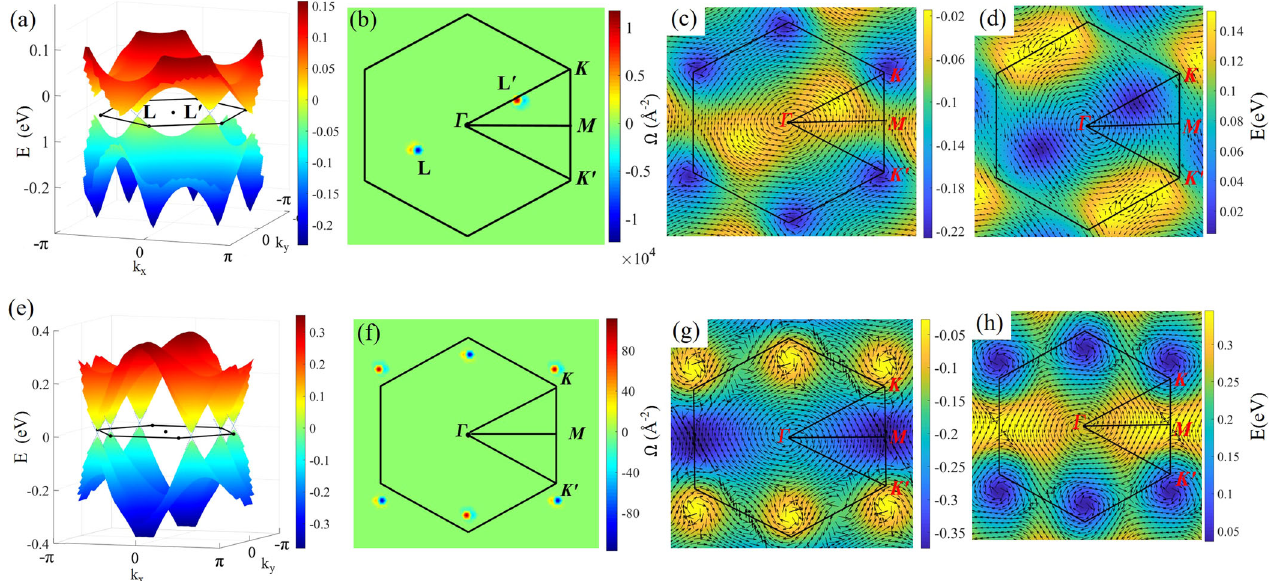
Fig. 5 The Hall conductivity nature of C 4 and C 6 systems. Upper panel for C 4 structure: a The 3D view of the band dispersions; b the momentum resolved Berry curvature for the occupied bands, where the color code is in the unit (Å − 2 ); c , d are the spin textures for the VBM and CBM, respectively. The color scale refers to the band energy (eV) with respect to the Fermi level and the black arrows represent the relative strength of the in-plane spin fi eld S xy . The lower panel is the same as the upper panel for C 6